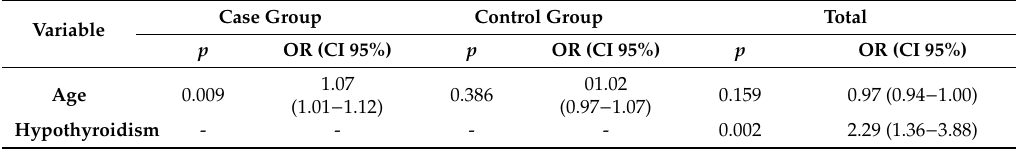
Table 3. Logistic regression model predicting sexual dysfunction and independent